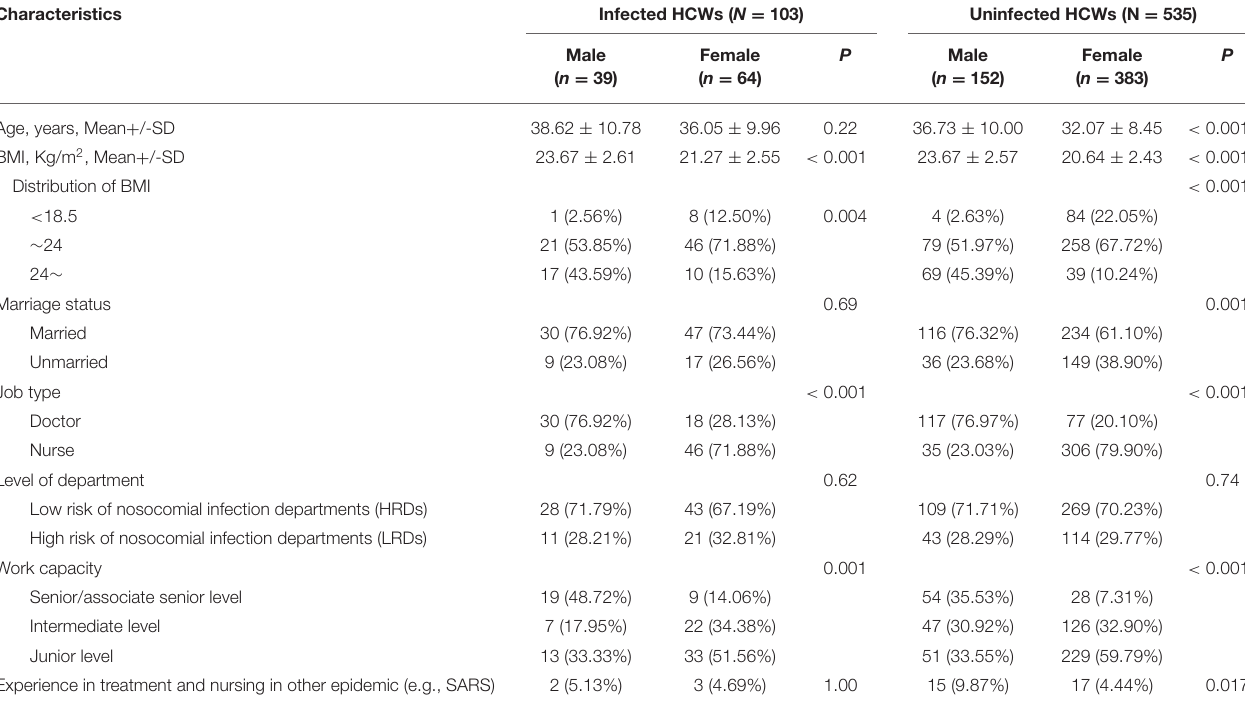
TABLE 1 | Basic characteristics between males and females in both infected and uninfected healthcare workers.